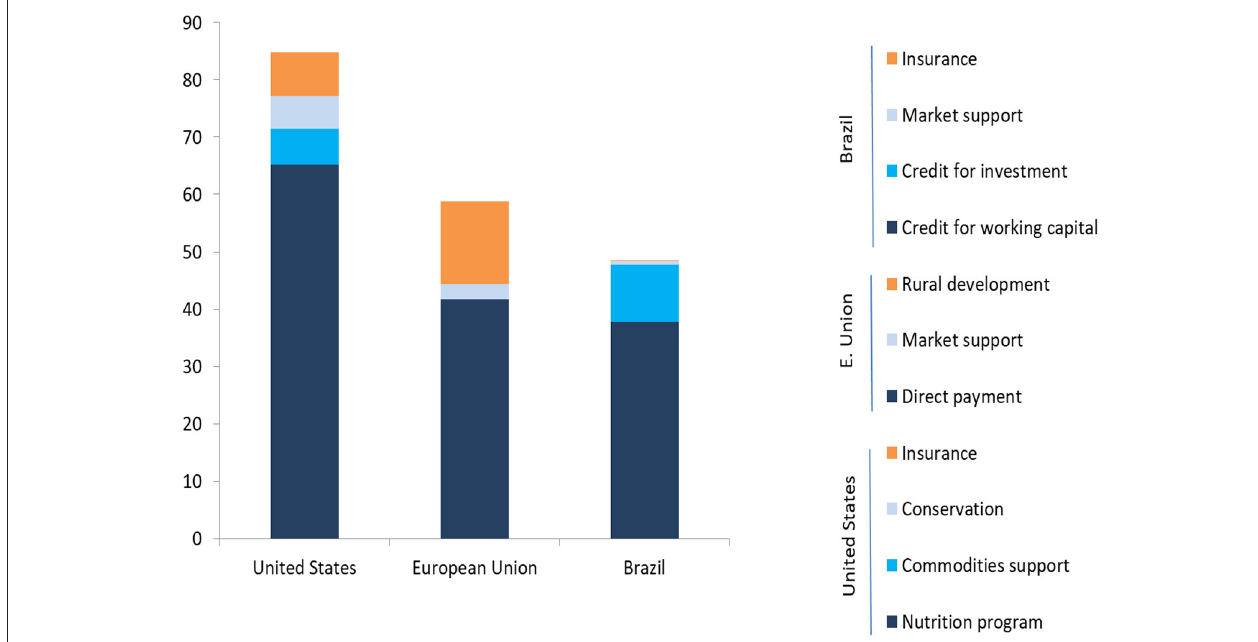
FIGURE 2 | Budget for principal agricultural policy programmes in 2020 (in USD). Source: MAPA (2019) and OECD